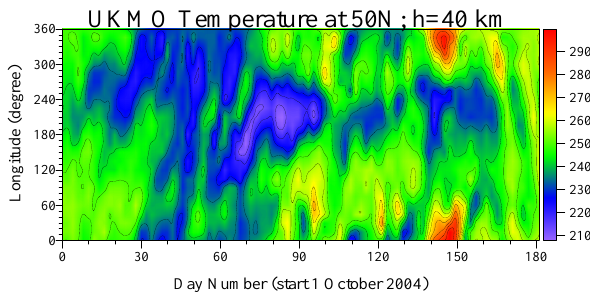
Figure 2 Fig. 2. Longitude-time cross section of the daily UKMO tempera- tures for 50 ◦ N latitude and at 40 km altitude for the period of time from 1 October 2004 to 31 March 2005.